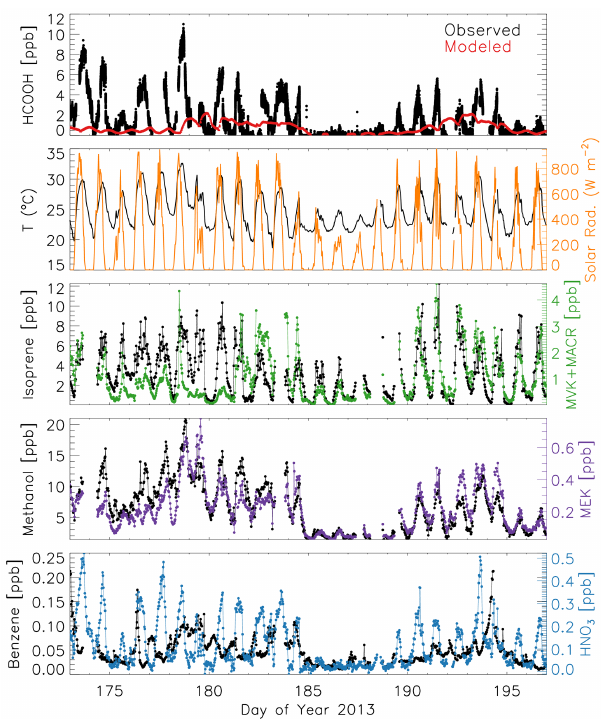
Figure 6. Timeline of chemical and meteorological measurements during the SOAS campaign (June–July 2013) near Brent AL, USA. The measured concentrations of HCOOH in black are compared to the simulated values in